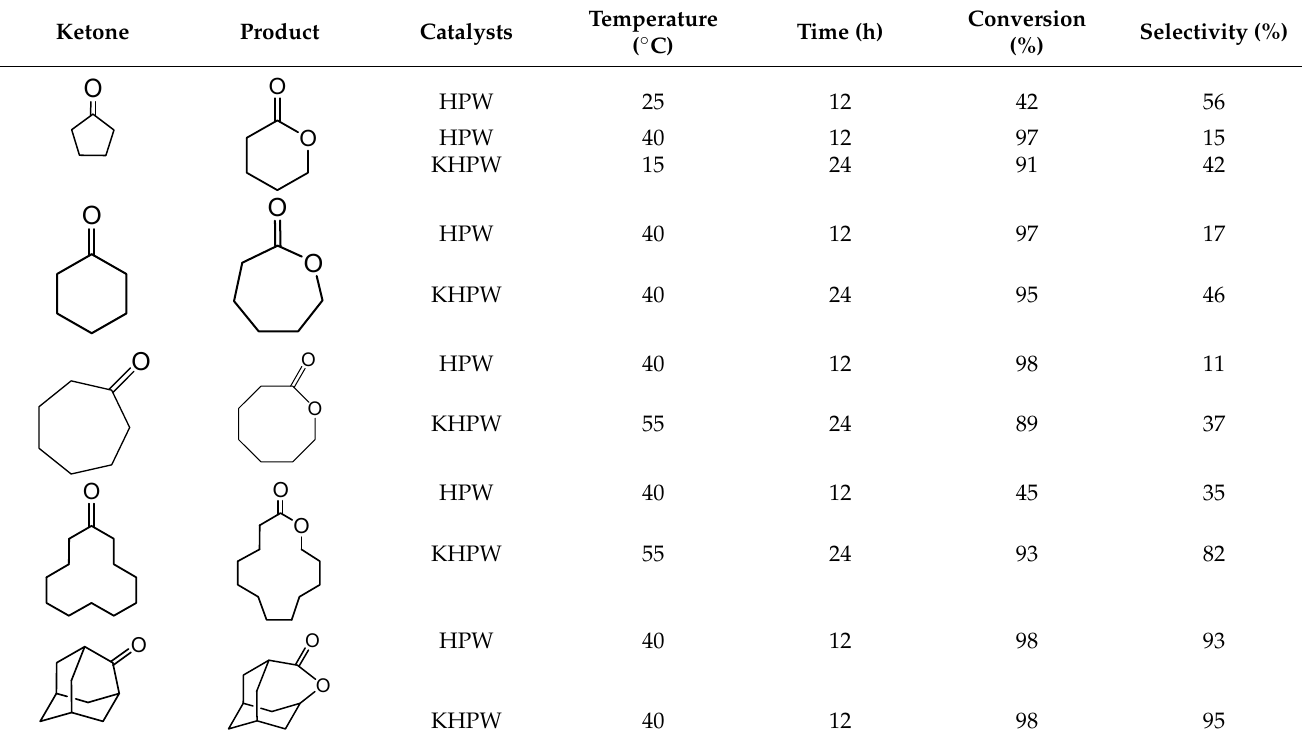
Table 7. Catalytic performances of HPW and KHPW for the oxidation of cyclic ketones to lactones.